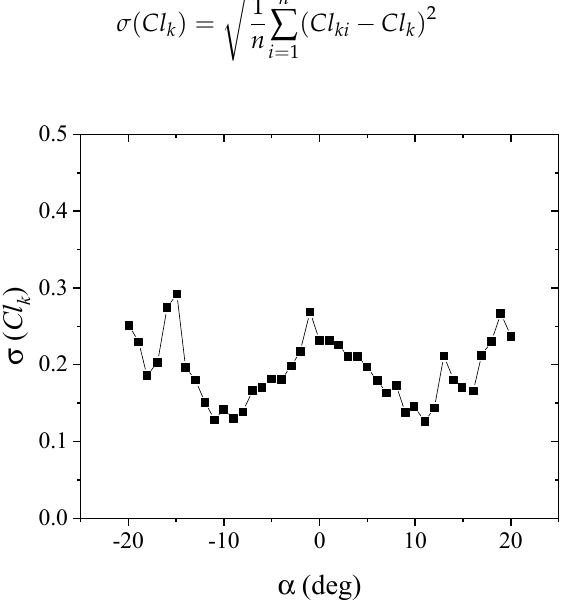
Figure 20. Standard deviations of the lift coefficient.